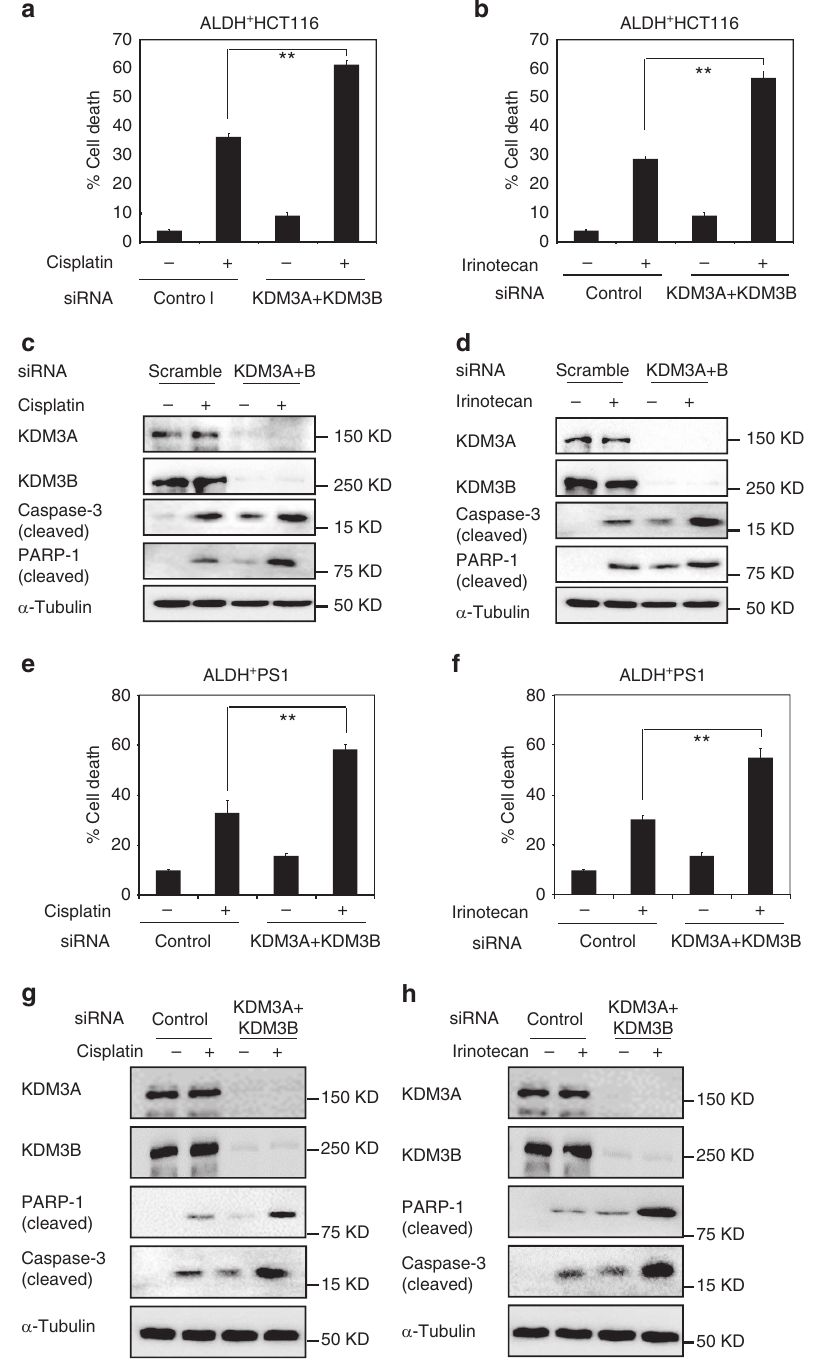
Figure 5 | KDM3A/B promote chemoresistance in human CSCs. ( a ) The knockdown of KDM3A/B enhanced cell death induced by cisplatin in ALDH þ HCT116 cells. Values are mean ± s.d. of triplicate samples from a representative experiment. * P o 0.05, ** P o 0.01, unpaired two-tailed